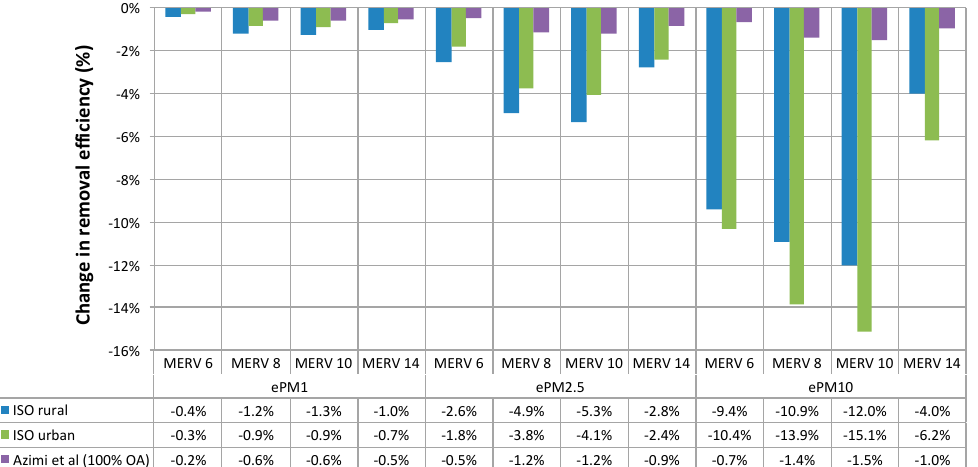
Figure 5. Absolute differences in estimates of e PM 1 , e PM 2.5 , and e PM 10 for four MERV-rated filters